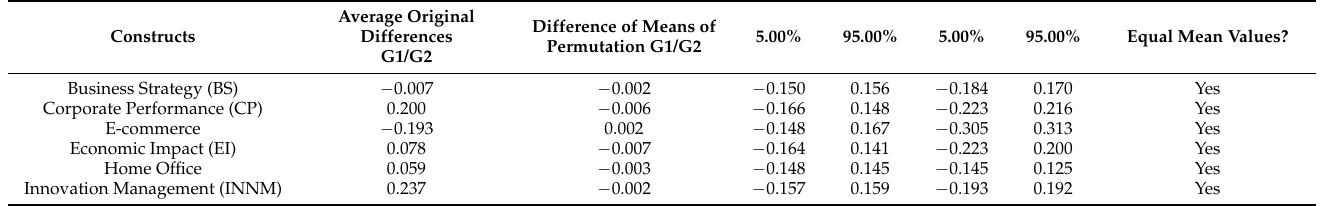
Table 7. Equality of means of the